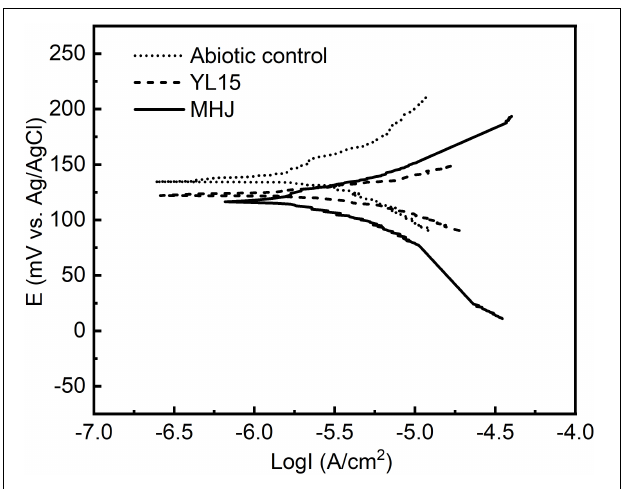
FIGURE 6 | Tafel curves of chalcopyrite electrodes in different systems.